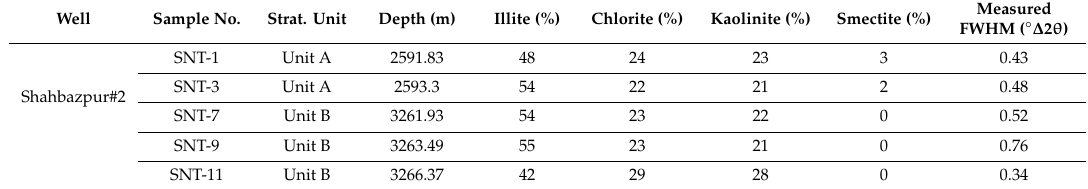
Figure 3. X-ray of clay fraction (2 µ m) showing the presence of major clay mineral type at the depth of Figure 3. X ‐ ray of clay fraction (2 μ m) showing the presence of major clay mineral type at the depth about ( A ) 2591.83 m of the Core-1 of Shahbazpur#2 well and ( B ) 3263.49 m of the Core-2 of Shahbazpur#2 of about ( A ) 2591.83 m of the Core ‐ 1 of Shahbazpur#2 well and ( B ) 3263.49 m of the Core ‐ 2 of well. Sm = smectite, Ch = chlorite, Ill = Illite and K = kaolinite. Shahbazpur#2 well. Sm = smectite, Ch = chlorite, Ill = Illite and K = kaolinite. Table 2. The relative percentage of clay minerals of some selective samples of the Shahbazpur#2 well. Well Sample